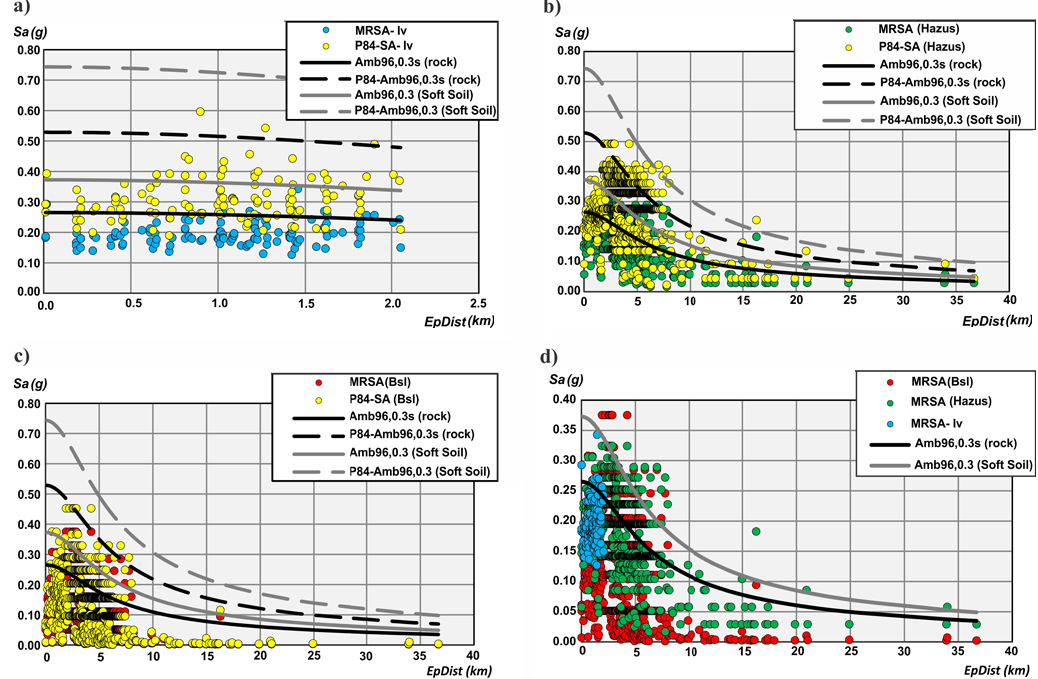
Fig. 10. MRSA and 84th percentile (period ∼ 0.3s) calculated at different epicentral distances applying (a) the indexed vulnerability method of Faccioli et al., (b) the HAZUS fragility curve and (c) the Bsl fragility curve. The last plot (d) compares the MRSAs calculated from all methodologies. MRSA and 84th percentile predicted by the GMPE of Ambraseys et al. (1996) for periods of 0.3s for rock sites (black) and soft soils (dark grey) are